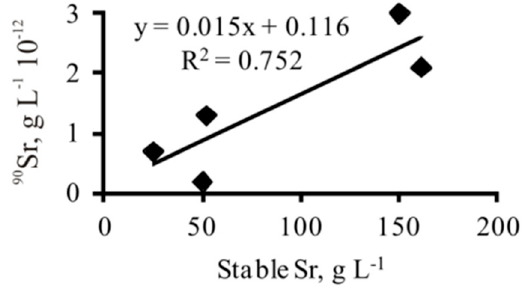
Figure 7. Relation between 90 Sr in 2014–2017 and sum of stable strontium isotopes in the Crimean saline lakes (data on stable Sr concentrations were taken from [46]).